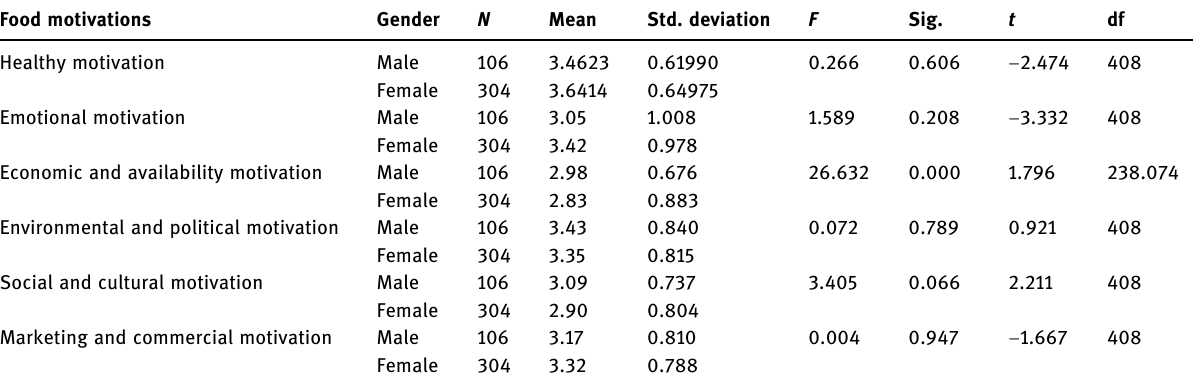
Table 1: T - test for gender and responsibility in buying food results Food